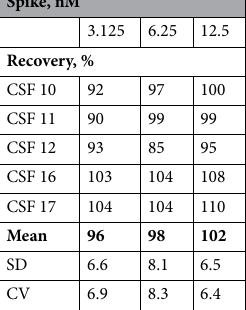
Table 2. Spike recovery of five different CSF samples.